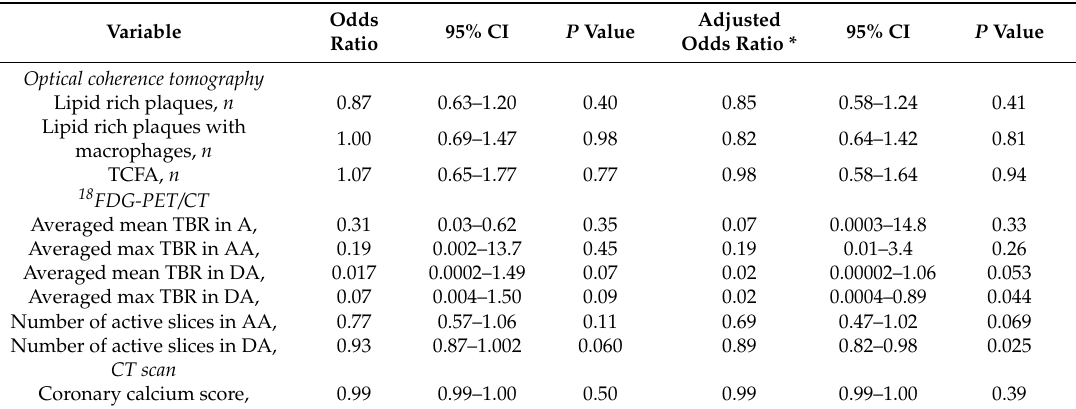
Table 3. Relation between atherosclerotic features and cystatin C values. Univariable and adjusted odds ratio * for the highest cystatin C group.